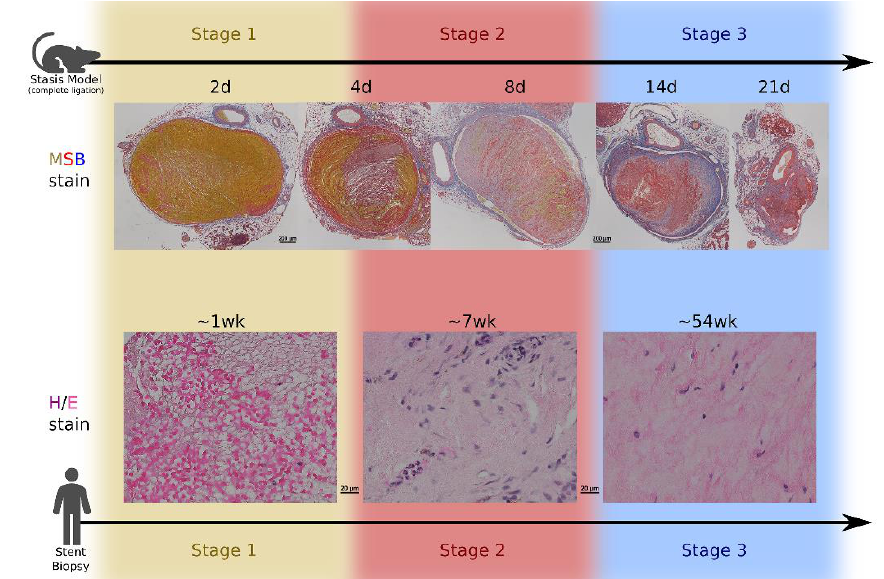
Figure 1. (Top) Histological time progression at 10× power showing venous thrombus resolution in a C57 murine IVC ligation model of DVT at 2, 4, 8, 14, and 21 days post-ligation. Formalin-fixed paraffin-embedded thrombus samples were stained using a modified Lendrum’s martius yellow, crystal scarlett, methyl blue (MSB) stain. ( 1 ) Erythrocytes are visualized in yellow, fibrin in red, and collagen in blue. As time progresses, clot composition transitions from erythrocytes to fibrin and then